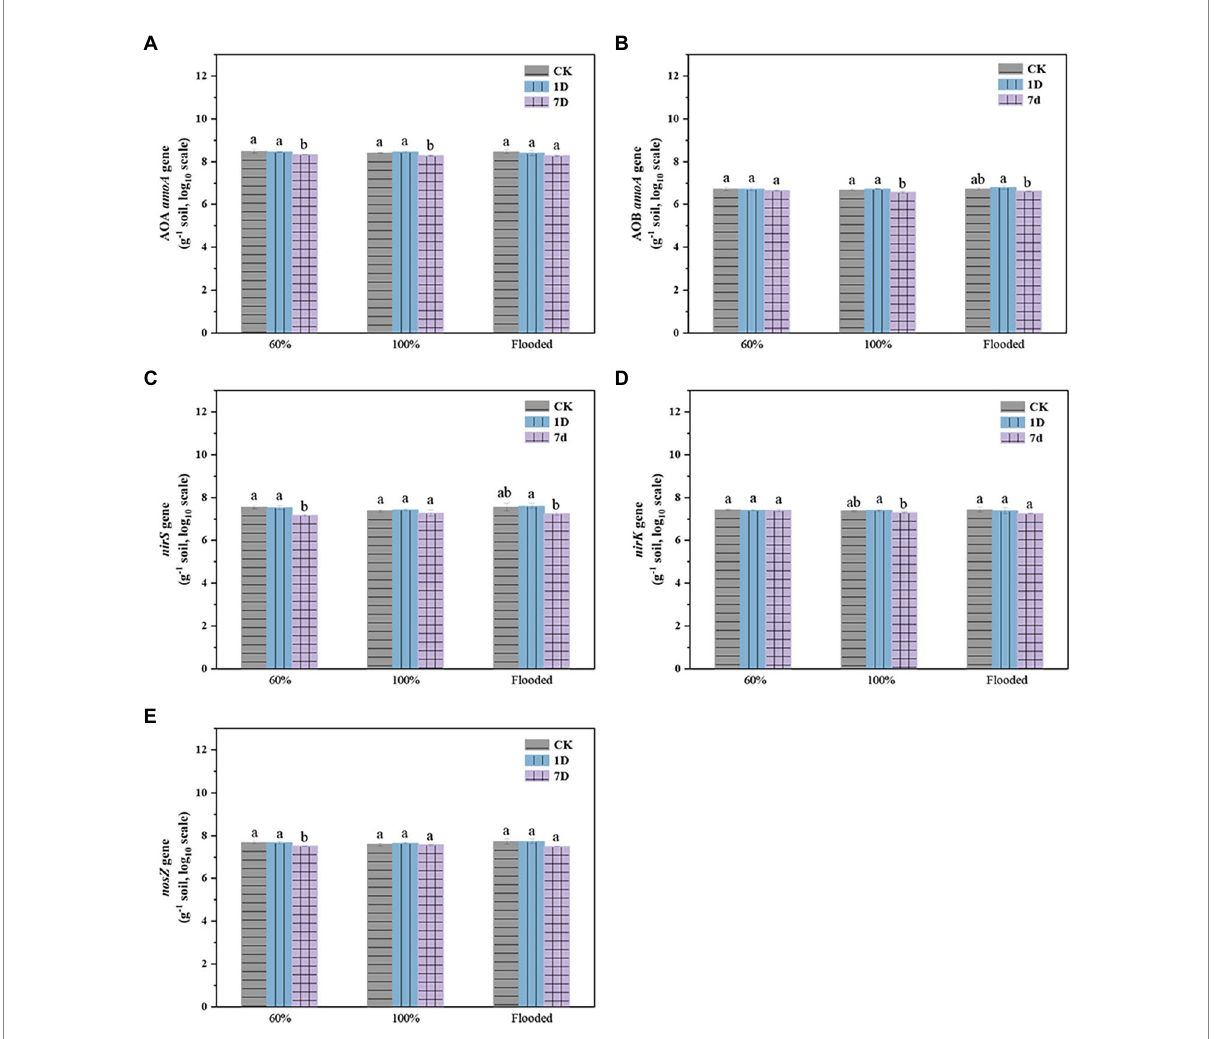
FIGURE 5 Abundance of the AOA amoA (A) , AOB amoA (B) , nirS (C) , nirK (D) , and nosZ (E) genes at different times (CK: control; 1D: the first day after thawing; 7D: the seventh day after thawing; a and b indicate significant differences among the different period, p < 0.05; error bars represent the standard error, n =